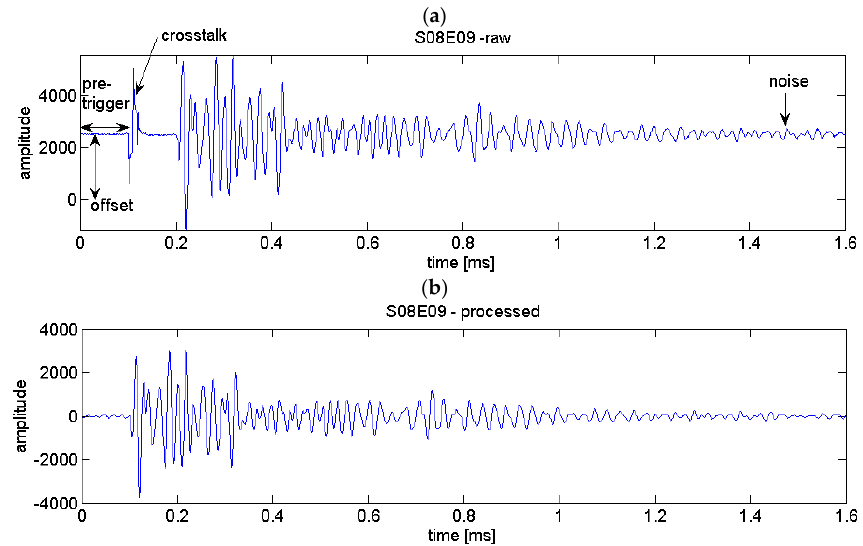
Figure 3. Example of an ultrasonic signal from the experiments described in Section 3 ( a ) before and ( b ) after data processing.